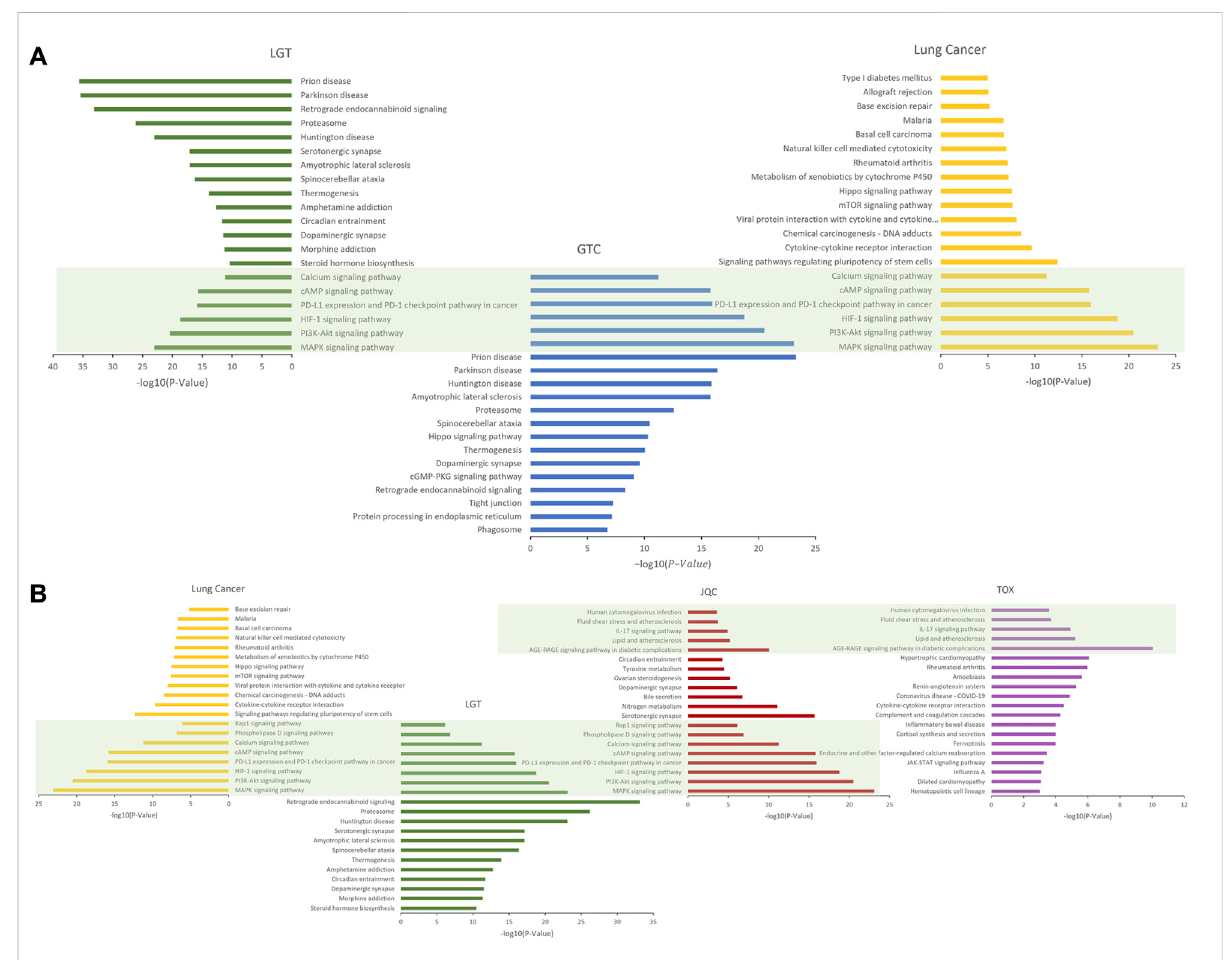
FIGURE 7 The enrichment pathway map of LGT and JQC in the treatment of lung cancer. (A) Target enrichment pathways of LGT, LUAD and GTC; (B) Gene enrichment pathways for toxic targets of LGT, LUAD, JQC, and